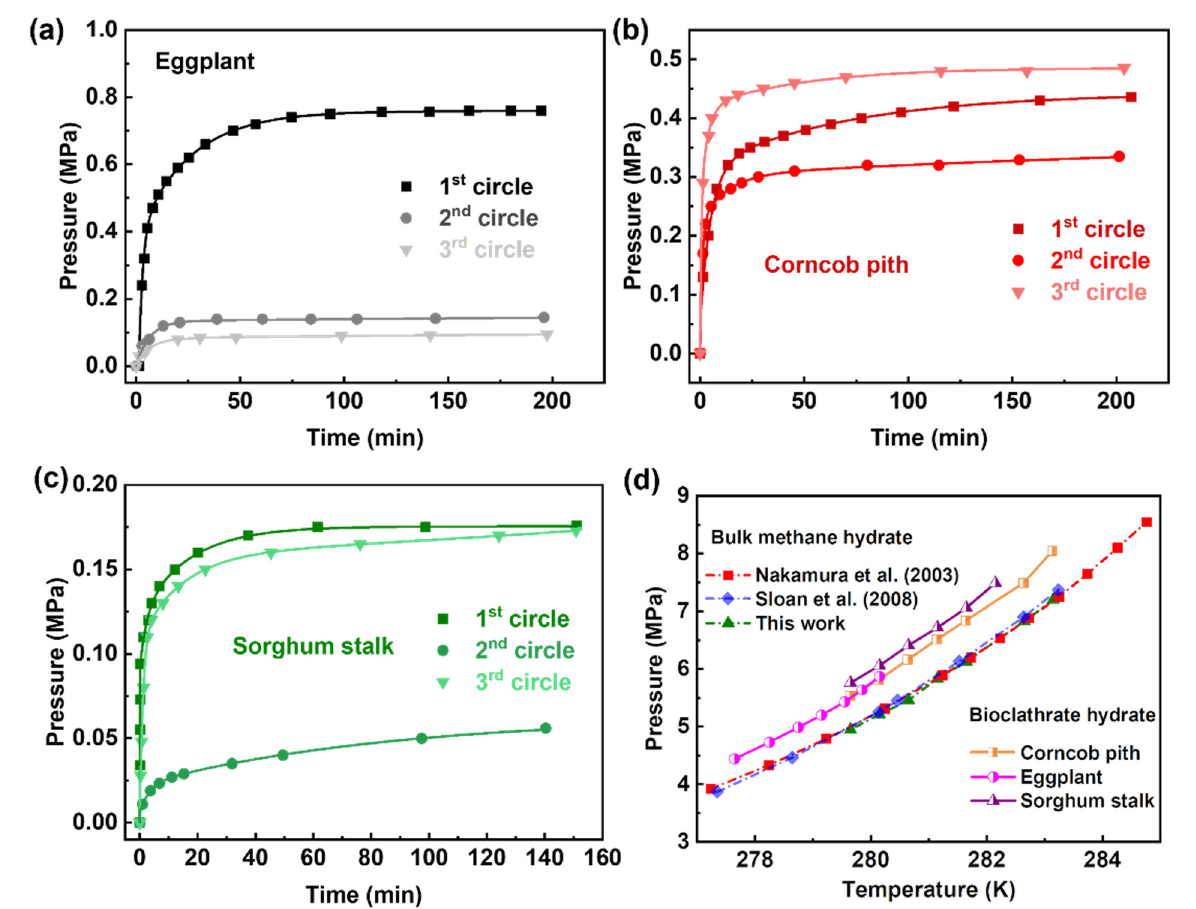
Figure 6. ( a – c ) Curves of methane gas release from eggplant, corncob pith, and sorghum stalk; ( d ) equilibrium curves of methane hydrate in eggplant, corncob pith, and sorghum stalk.